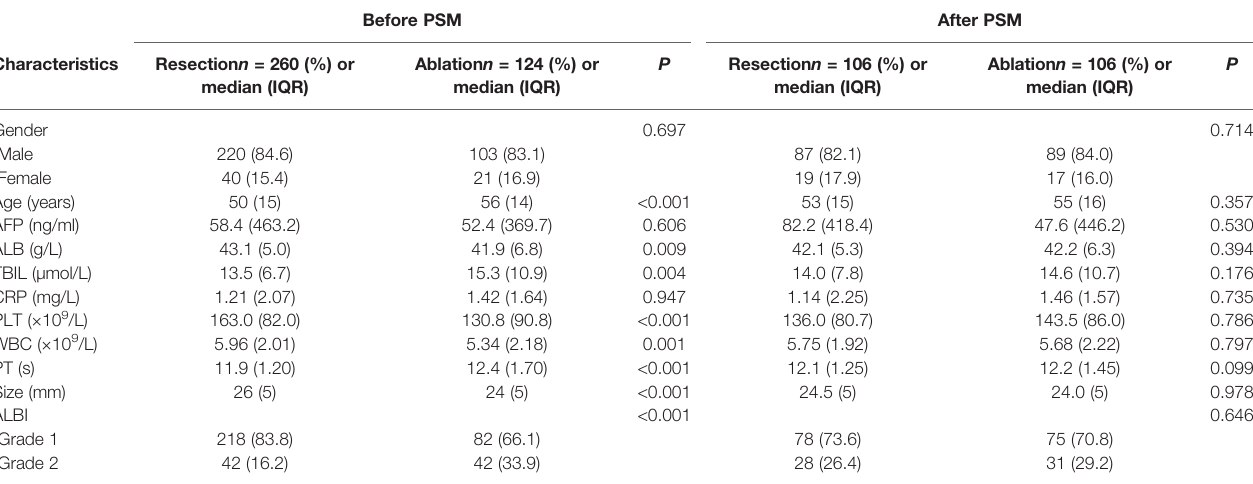
TABLE 1 | Baseline characteristics of patients before and after propensity score